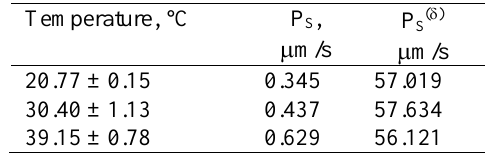
Table 1. The effect of Temperature on Membrane Salt Permeabilities, (P S ) and Stagnant Layer Salt Permeabilities, (P S(  ) ) obtained as fitting parameters for Eq. 7